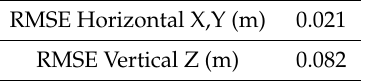
Table 4. Hovering performance error.